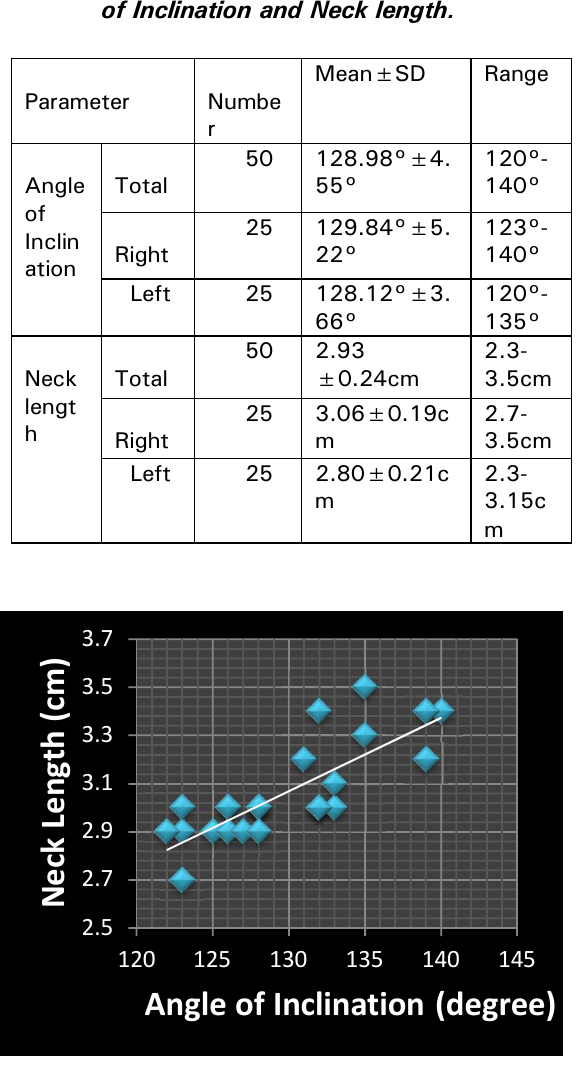
Graph 1: Correlation between right side Angle of inclination and neck length of femur: increased angle of inclination with increase in neck length.